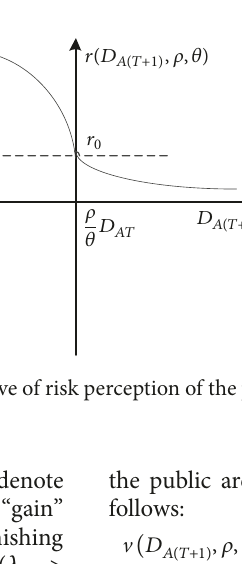
Figure 2: Curve of perceived value of the public.